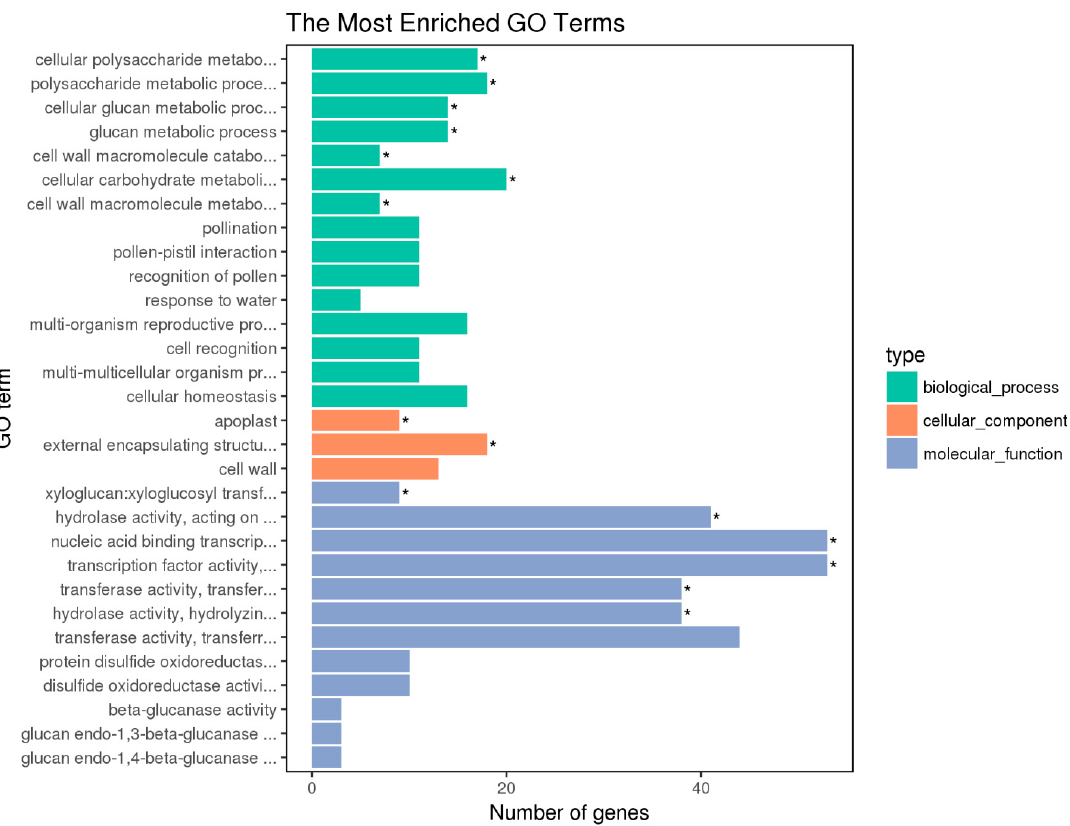
Figure 2. GO enrichment analysis of DEGs between T2 and CK treatments. The 30 most enriched GO terms including upregulation and downregulation are shown. Asterisks indicate significantly enriched GO terms ( q < 0.05).